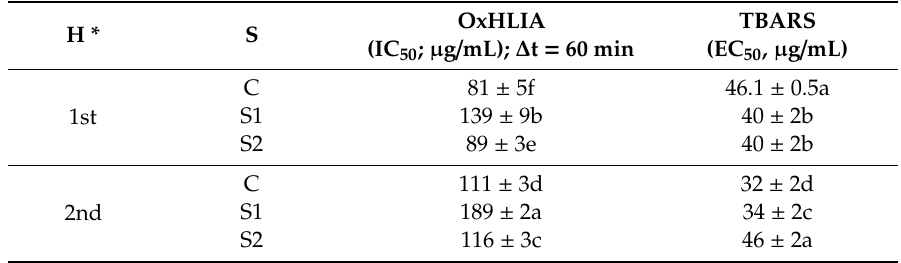
Table 9. Antioxidant activity of Centaurea raphanina subsp. mixta leaves’ hydroethanolic extracts in relation to harvesting time and salinity level (mean ± SD, n =